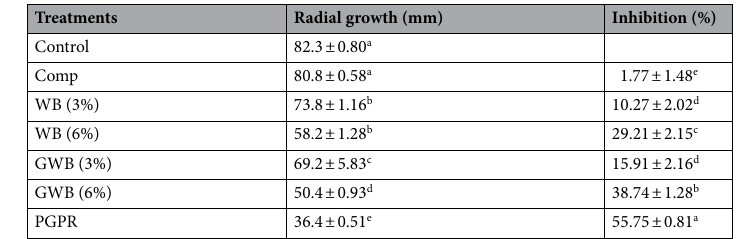
Table 4. In vitro mycelium radial growth (mm) and inhibition (%) of Alternaria solani in control (un-amended), compost (Comp, 20%), PGPR ( Bacillus subtilis ), wood biochar (WB, 3%, 6%), green waste biochar (GWB, 3%, 6%) amended PDA. Given results are mean values ± standard error followed by different letters in the superscript within a column denotes significant differences according to Tukey’s HSD test ( P ≤